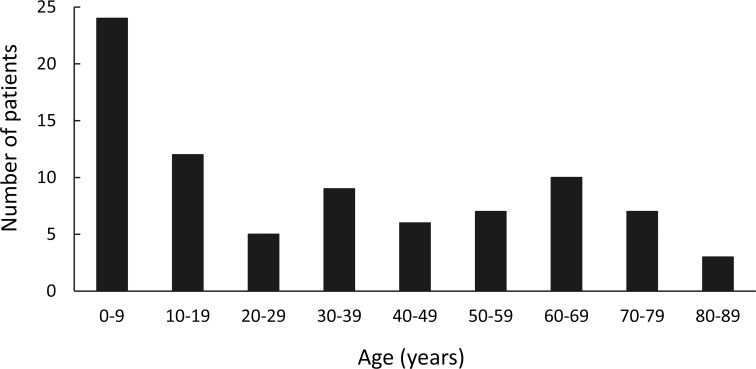
Age distribution of 83 patients with orbital complications of sinusitis.Age peaked at 0–9 years, followed by 10–19 years. An additional peak occurred at 60–69 years.